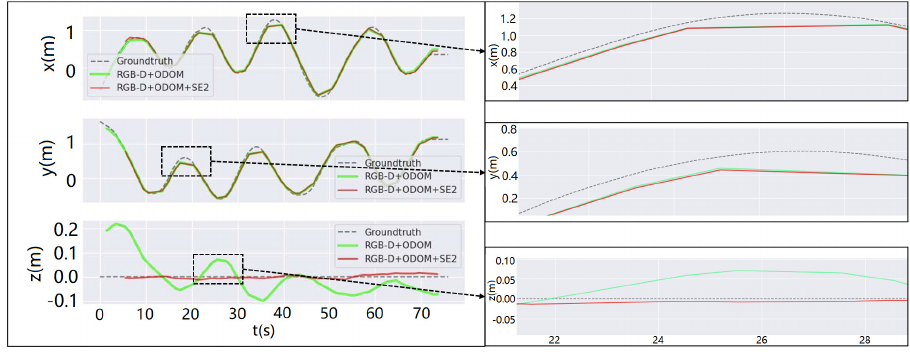
Figure 6. Comparison of results mapped on three axes with and without plane